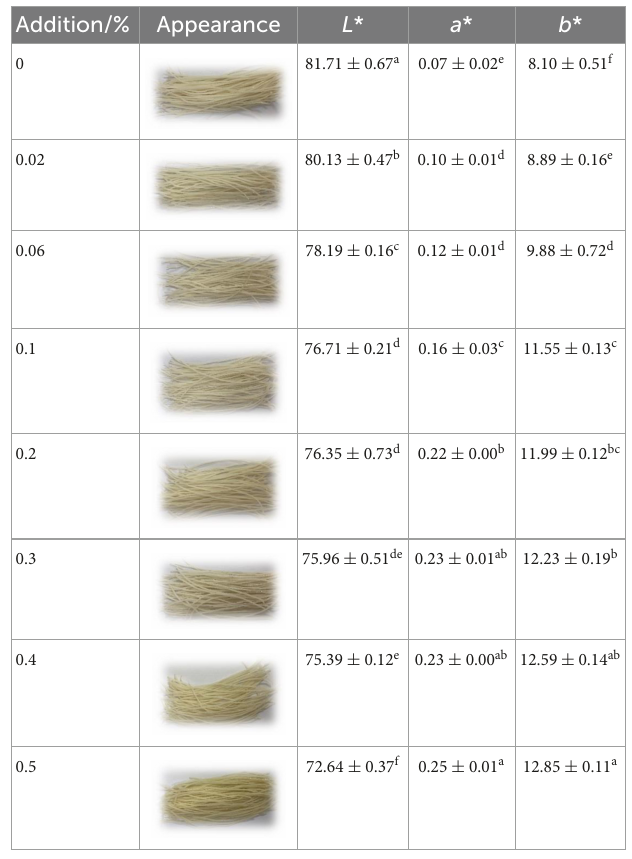
Valuesarepresentedasthemean ± SDofthreereplicatesamples.Thismeansinacolumnthat sharesthesamelettersdonotsignificantlydiffer( p < 0.05).